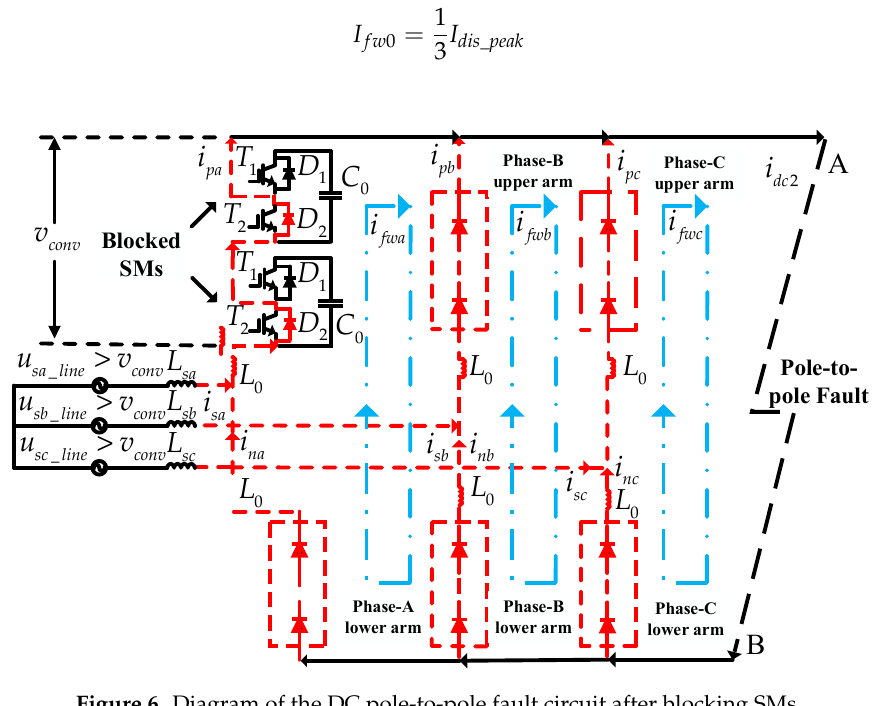
Figure 6. Diagram of the DC pole-to-pole fault circuit after blocking SMs.